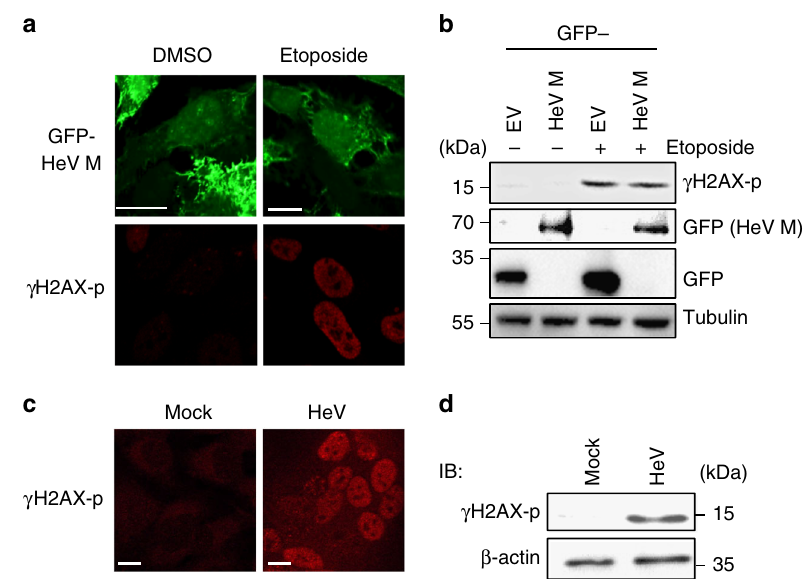
Fig. 8 HeV infection but not HeV M protein expression induces DNA damage. a HeLa cells transfected to express GFP-HeV M protein without (DMSO) or with etoposide treatment were fi xed 16 h p.t., immunostained for γ H2AX phosphorylated at S139 ( γ H2AX-p) and imaged by CLSM. Images are representative of ≥ 15 fi elds of view. b Lysates of HEK-293T cells transfected to express GFP alone (empty vector (EV)) or GFP-HeV M protein and treated at 16 h p.t. without or with etoposide (3 h), were analyzed by IB using the indicated antibodies (data are representative of two independent experiments). c HeLa cells infected with HeV (MOI 5; which results in c. 100% cells infected) were fi xed 24 h p.i. and immunostained for γ H2AX-p prior to imaging by CLSM (images representative of ≥ 15 fi elds of view from three biological replicates). d Lysates of mock or HeV-infected HeLa cells were collected at 24 h p. i. and analyzed by IB using the indicated antibodies (data representative of three biological replicates). Scale bars correspond to 15 μ